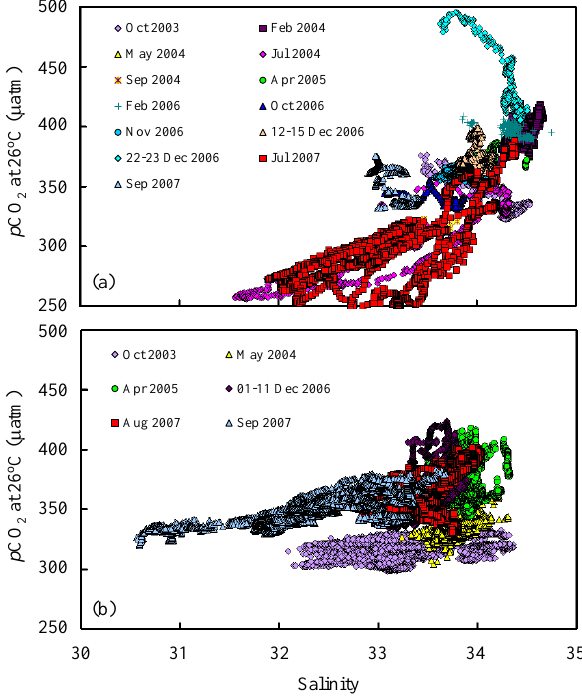
Fig. 10. Scatter plots of temperature-normalized p CO 2 as a function of salinity in domain A (a) and in domain C (b) .